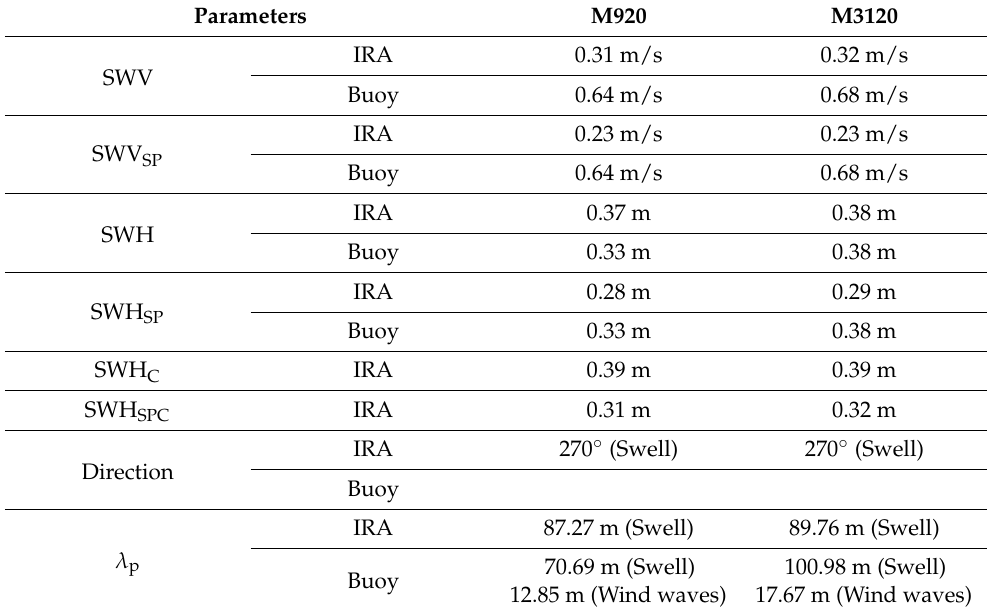
Table 5. The ocean wave parameters retrieved from the airborne hybrid InSAR images and m- measured by the GNSS